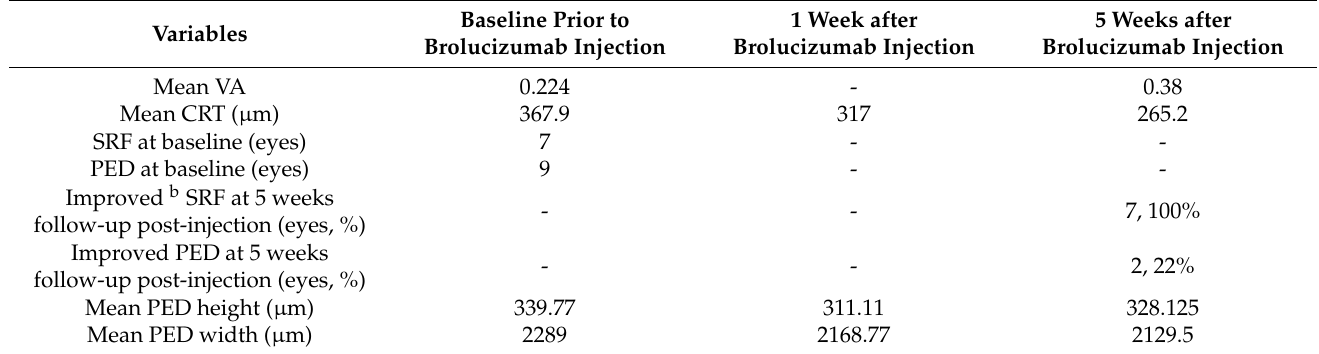
Table 2. Anatomical and visual outcomes in all patients at baseline before injection, 1 week and 5 weeks post-injection (all patients, n = 10).